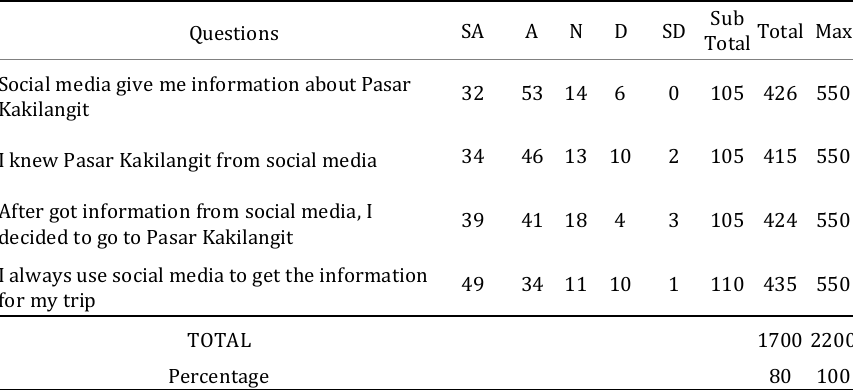
Table 1 Pre-Consumption Data Findings